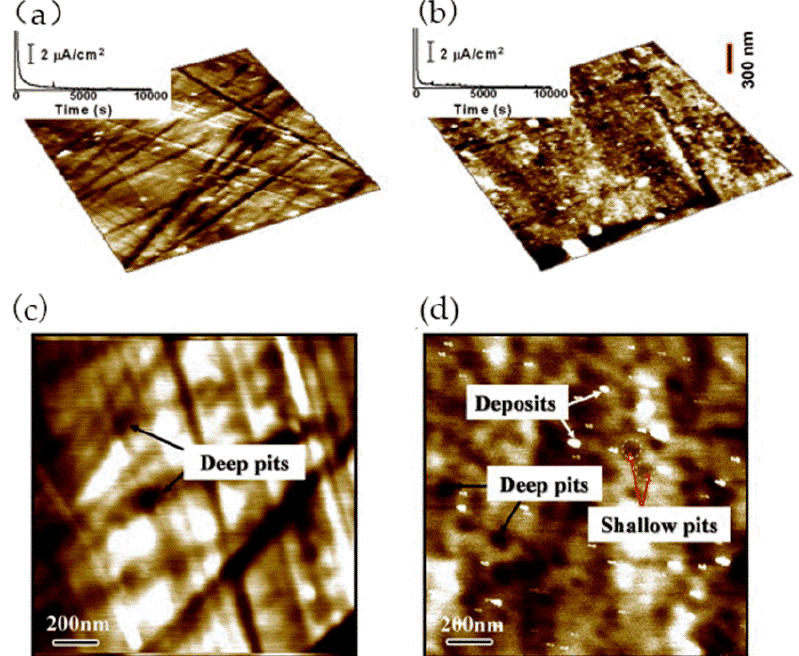
Figure 4. AFM imagines of the surfaces of amorphous and crystallized Ni50Nb50 alloys after polarization at 1.0 V in 1 mol / L HCl solution. ( a , b ) Surface morphologies of the amorphous and crystallized samples. Inserts are the corresponding I–t curves during potentiostatic treatments. ( c , d ) High-magnification images of selective areas in amorphous and crystallized samples. Adapted with permission from Reference [39]; copyright 2010 Elsevier Ltd.